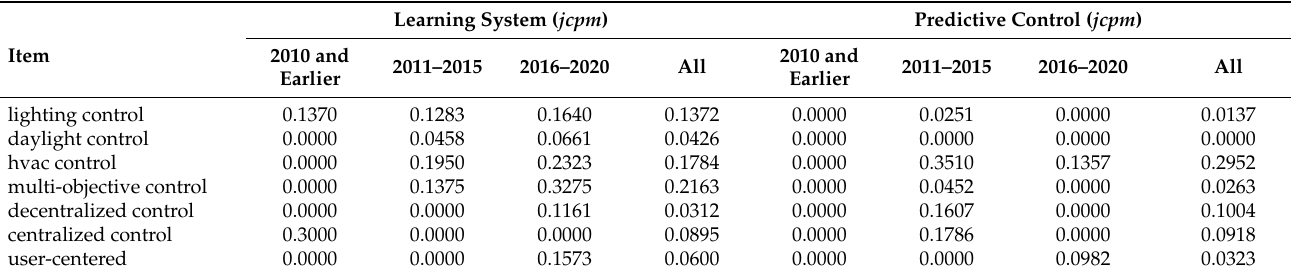
Table 7. Joint conditional probability measure ( jcpm ) of the items learning system and predictive control networked with different building trades and centralized and decentralized system designs, determined by using VOSviewer.